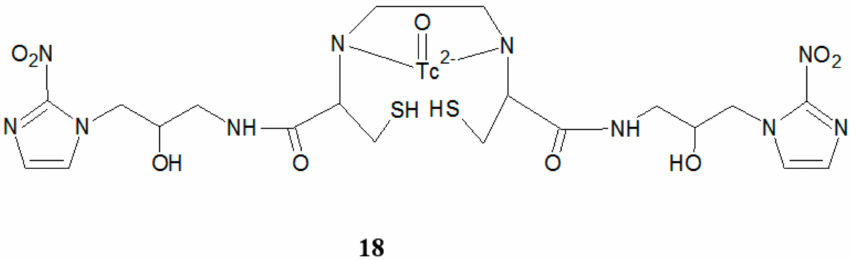
Figure 10. The structure of 99m Tc-EC-MISO.